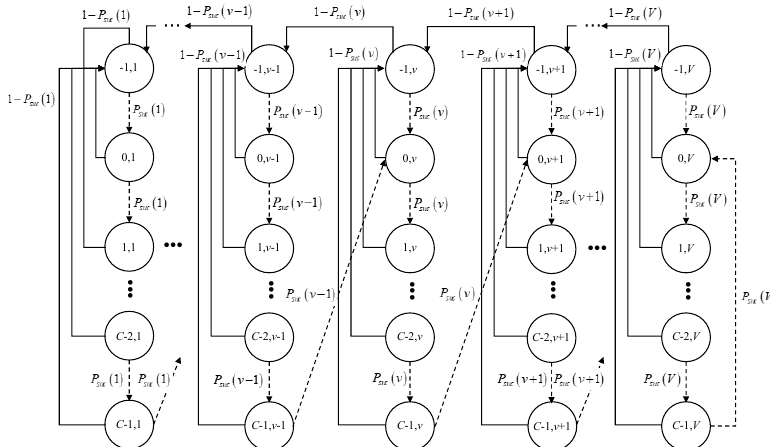
Figure 5. Markov chain model for the platoon velocity in